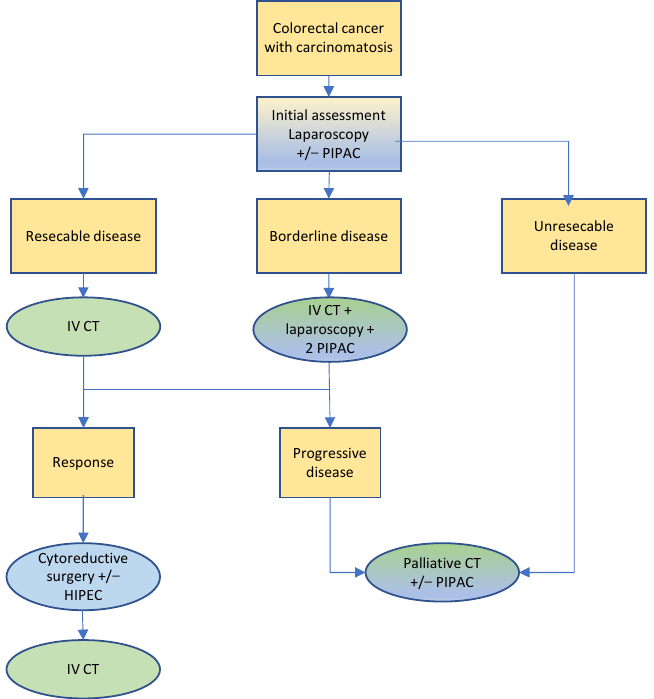
Figure 4. Treatment algorithm for colorectal